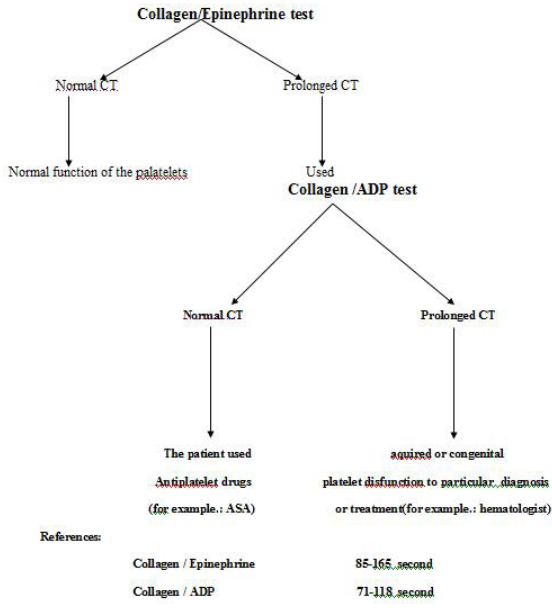
Figure 1. The interpretation of the CT test in